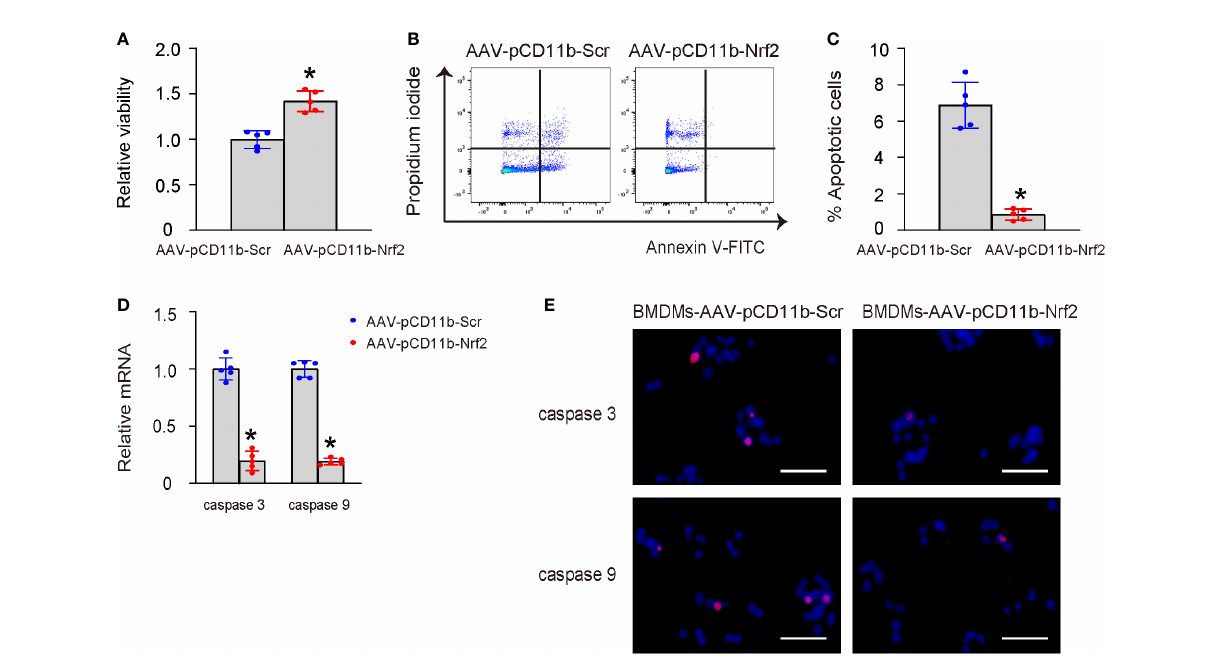
FIGURE 5 Nrf2-macrophages improve survival of LPS-treated HMMECs. HMMECs were treated with LPS, and then co-cultured with AAV-pCD11b-Nrf2- transduced or control AAV-pCD11b-Scr-transduced BMDMs. (A) CCK-8 assay for LPS-treated HMMECs co-culture with AAV-pCD11b-Nrf2- transduced or AAV-pCD11b-Scr-transuced BMDMs. (B, C) Annexin V assay for HMMECs, shown by representative fl ow charts (B) and by quanti fi cation (C) . (D) RT-qPCR for cleaved caspase 3 and caspase 9 in BMDMs. (E) Immunocytochemistry for cleaved caspase 3 and caspase 9 in BMDMs. *p<0.05. Scale bars were